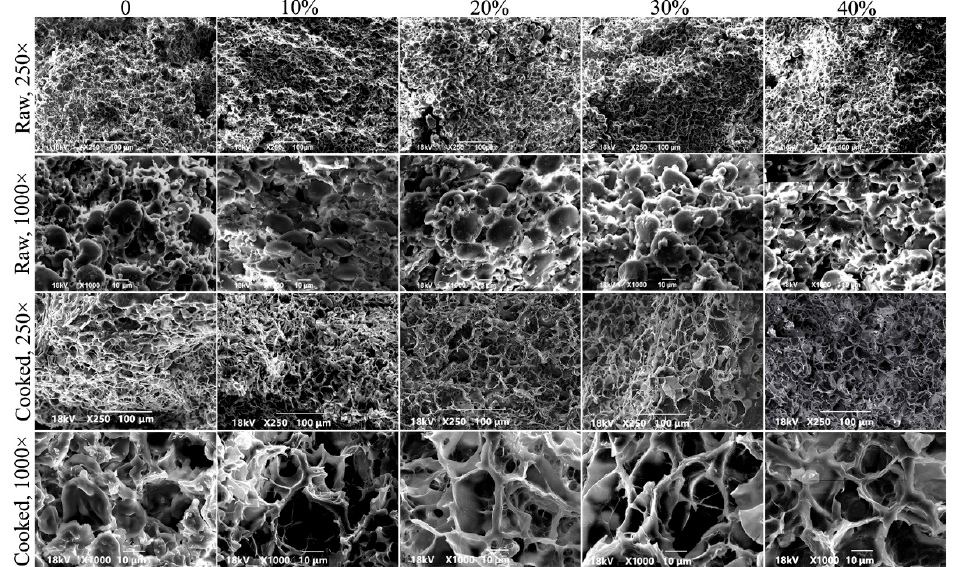
Figure 4. SEM micrographs of wheat flour noodles supplemented with different levels of Chinese yam powder.